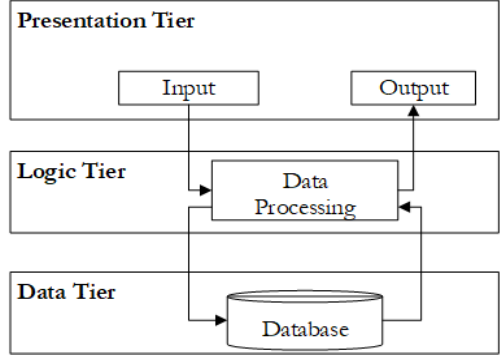
Figure 2. Multi-tier architecture.